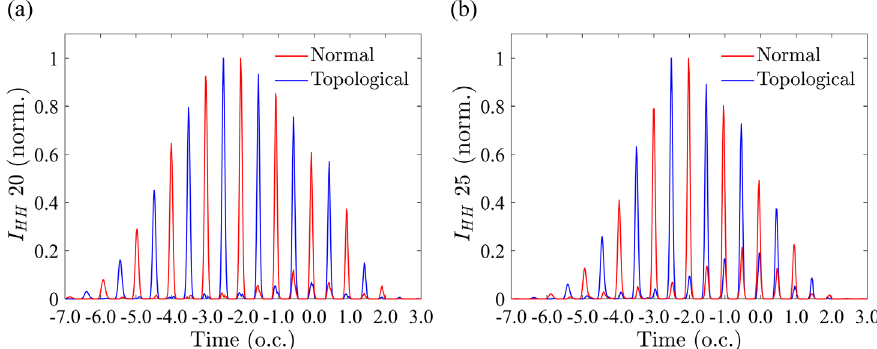
FIG. 9. Normalized intensities of (a) the 20th and (b) 25th order HHPTs for the NP and TP points under a 240-fs laser field. Because of the large difference in radiation intensity, only 10 optical cycles with the obvious values are shown.